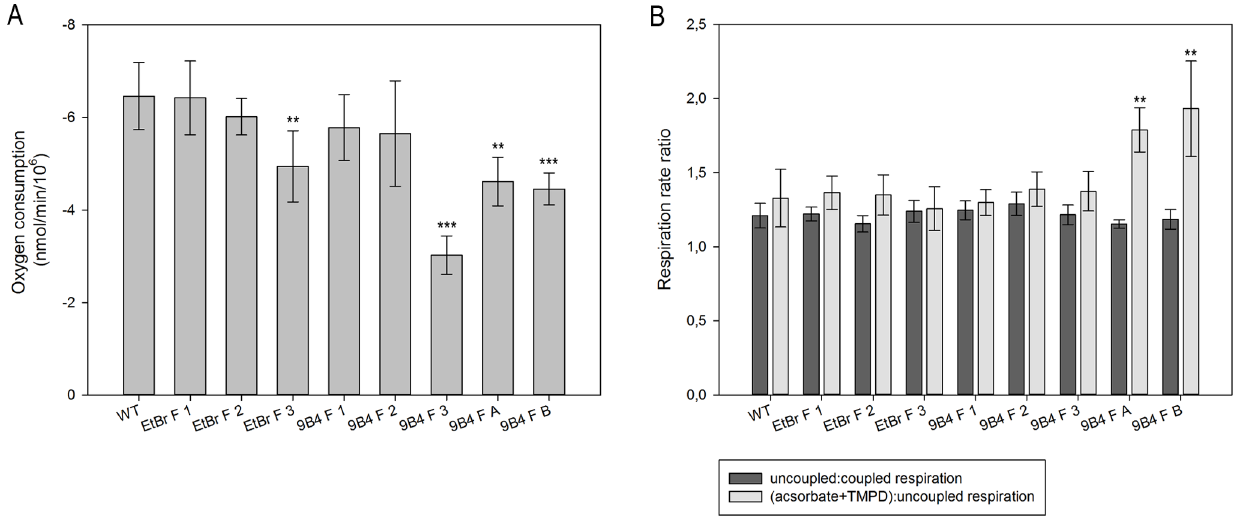
Figure 5. Polarographic respiration measurements of PC-3 fusion cells. A Endogenous oxygen consumption rate of intact PC-3 fusion cells was measured in TD buffer and normalized to cell number of the sample. B Relative oxygen consumption rates of PC-3 fusion cells were measured in TD buffer in absence and presence of the uncoupler DNP (dark grey bars). COX capacity of PC-3 fusion cells was measured as relative uncoupled respiration rate at 0.4 mM TMPD in antimycin-treated cells (light grey bars). The data represent means 6 SD from 4–6 independent experiments. *P , 0.05, **P , 0.01, ***P , 0.001. doi:10.1371/journal.pone.0073207.g005 (Fig. 2). After 24 h fusion, we could detect r 0 cells with green line stably expressing MTS-DsRed (F 1–3, see Table 1). It must be fluorescent mitochondria (Fig. 2, A1 and B1) as well as fused cells noted that all the described fusion cell lines arose from multiple also exhibiting MTS-DsRed from cytoplast mitochondria (Fig. 2, cell clones pooled together after the fusion event. A2 and B2) throughout the complete mitochondrial network In addition, genomic DNAs from all fusion cell lines were tested (Fig. 2, A3 and B3). The mitochondrial red fluorescent staining for the integrated DsRed gene sequence. As shown in Fig. 3 both r 0 acceptor cells and fusion cell lines do not have any was completely lost in nearly all cells after two weeks. Additionally, PC-3 r 0 cells were fused with cytoplasts from a PC-3 donor cell